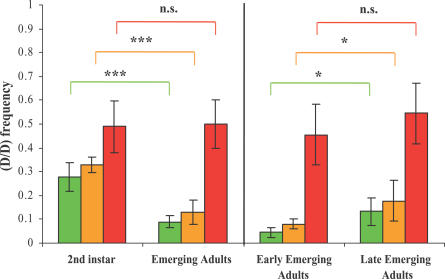
Frequency of Homozygotes (D/D) Compared to Heterozygotes (D/S) during DevelopmentThe frequency of (D/D) individuals is indicated for second instar and emerging adults on the left. On the right, adults are divided into early and late emerging adults. (i) MAURIN-D ((D2/D2) versus (D2/S), green), (ii) BIFACE-D ((D3/D3) verus (D3/S), orange), and (iii) BIFACE-DFix x MAURIN-D ((D2/D3) versus (D3/S), red). The bars indicate one error-type. Significant frequency differences between the different stages are indicated (n.s., p-value > 0.05; *, p-value < 0.05; **, p-value < 0.01; and ***, p-value < 0.001).